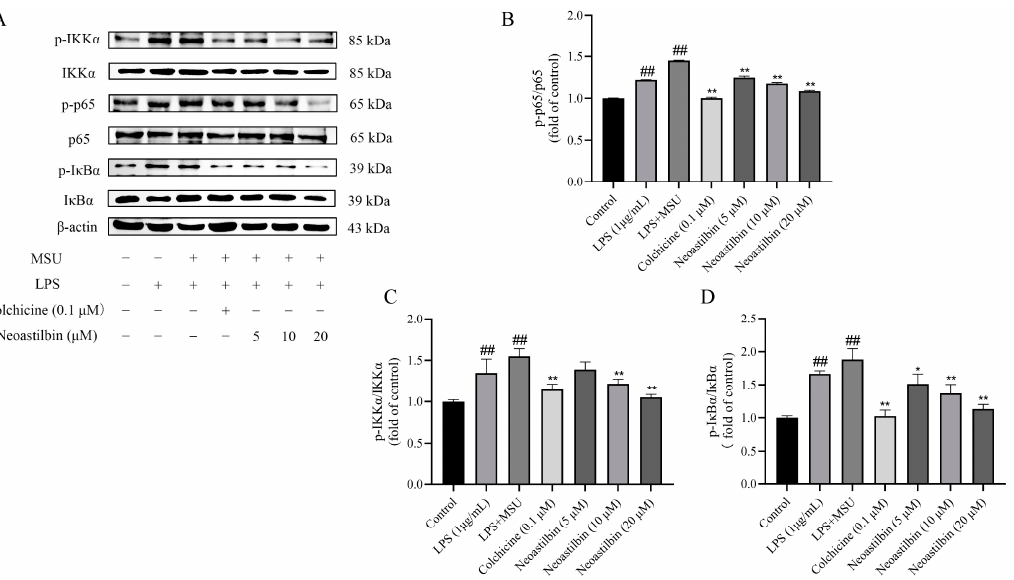
Figure 3. Effects of neoastilbin on protein expression of NF- κ B pathway in THP-1-derived macro- phages. ( A ) Phosphorylated and non-phosphorylated expressions of IKK α , p65 and I κ B α . ( B – D ) The ratio of protein expression of p- IKK α /IKK α , p-p65/p65 and p- I κ B α /I κ B α . Data in the figures represent the means ± SD; significant differences among different groups are indicated as ## p < 0.01 vs. control group, * p < 0.05, ** p < 0.01 vs. LPS + MSU group ( n = 3).